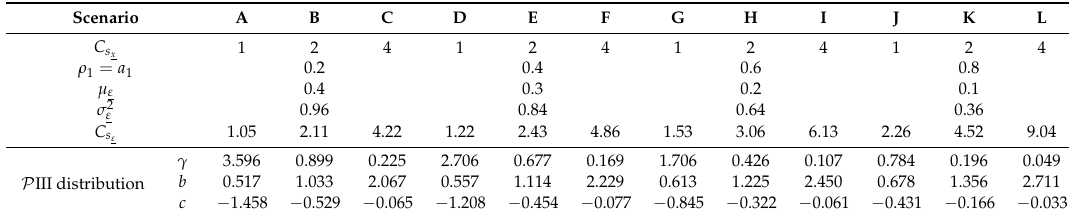
Table 1. Summary of target statistics for all scenarios (in all cases, µ x = 0.5 and σ 2 x = 1).